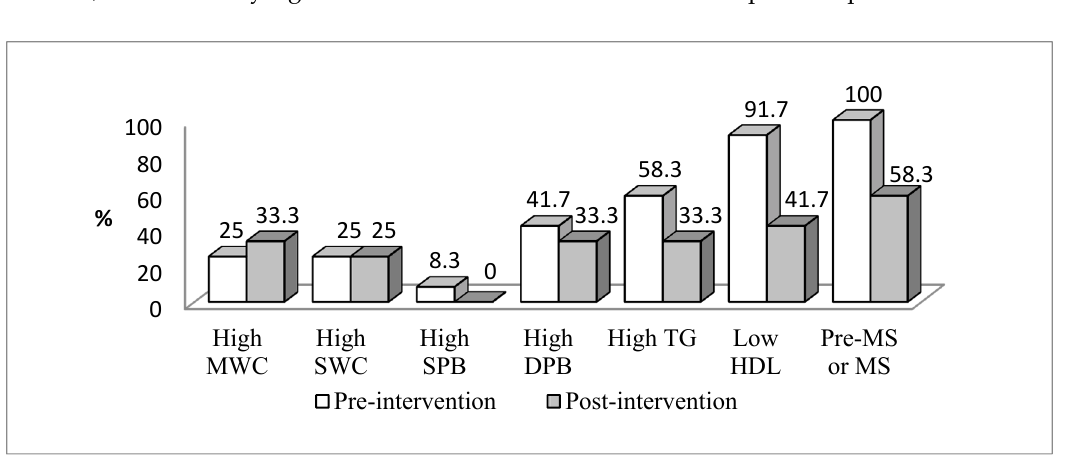
Figure 1. Changes in metabolic syndrome components in adolescents before and after 14 weeks of intervention.